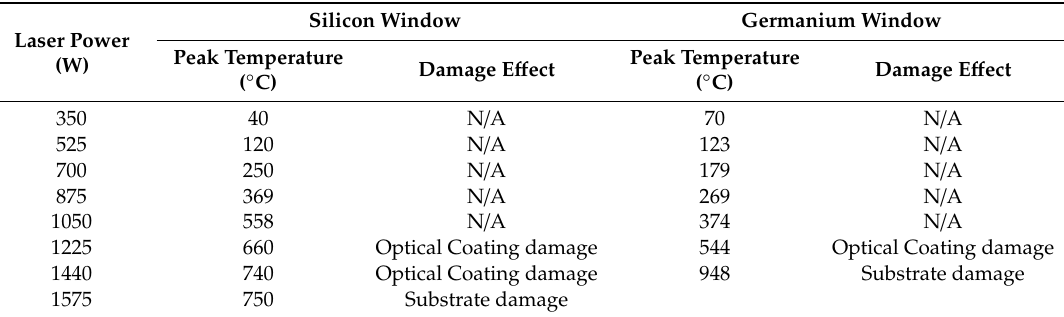
Table 4. Experimental results of the continuous laser.